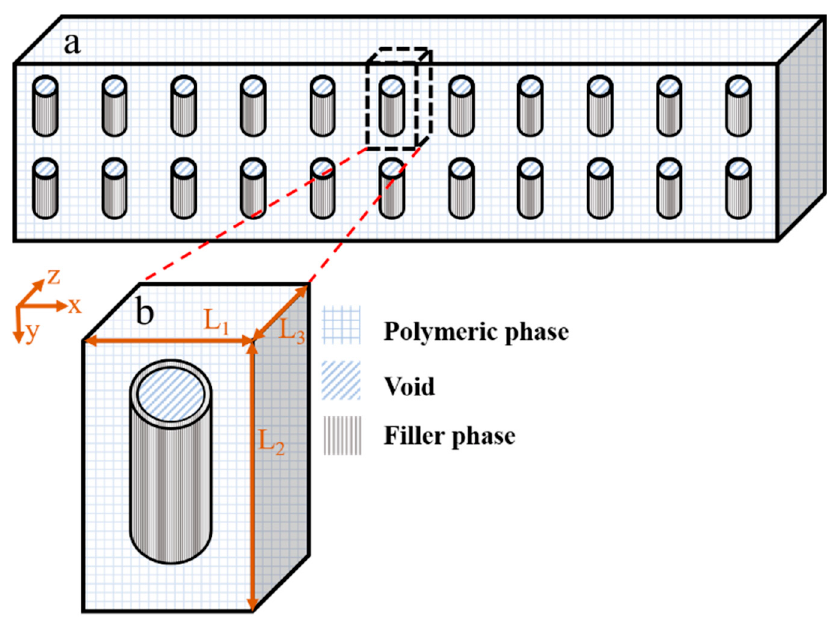
Figure 1. ( a ) A schematic diagram of the cross-section of homogenous dispersed nanotube particles in a mixed-matrix membrane and ( b ) a schematic diagram of a repetitive unit element including the polymer and filler phases as well as void volume inside the nanotube along with the parameter giving its dimensions.